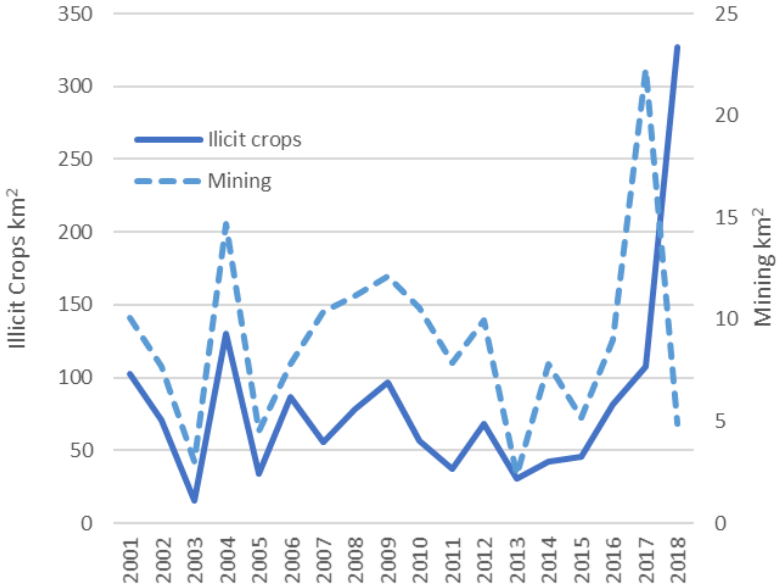
Figure 4. Annual extent of forest loss from the Global Forest Change (GFC) database associated to areas under the influence of illicit crops and alluvial mining identified in 2016 by the United Nations Office for Drugs and Crime (UNODC).